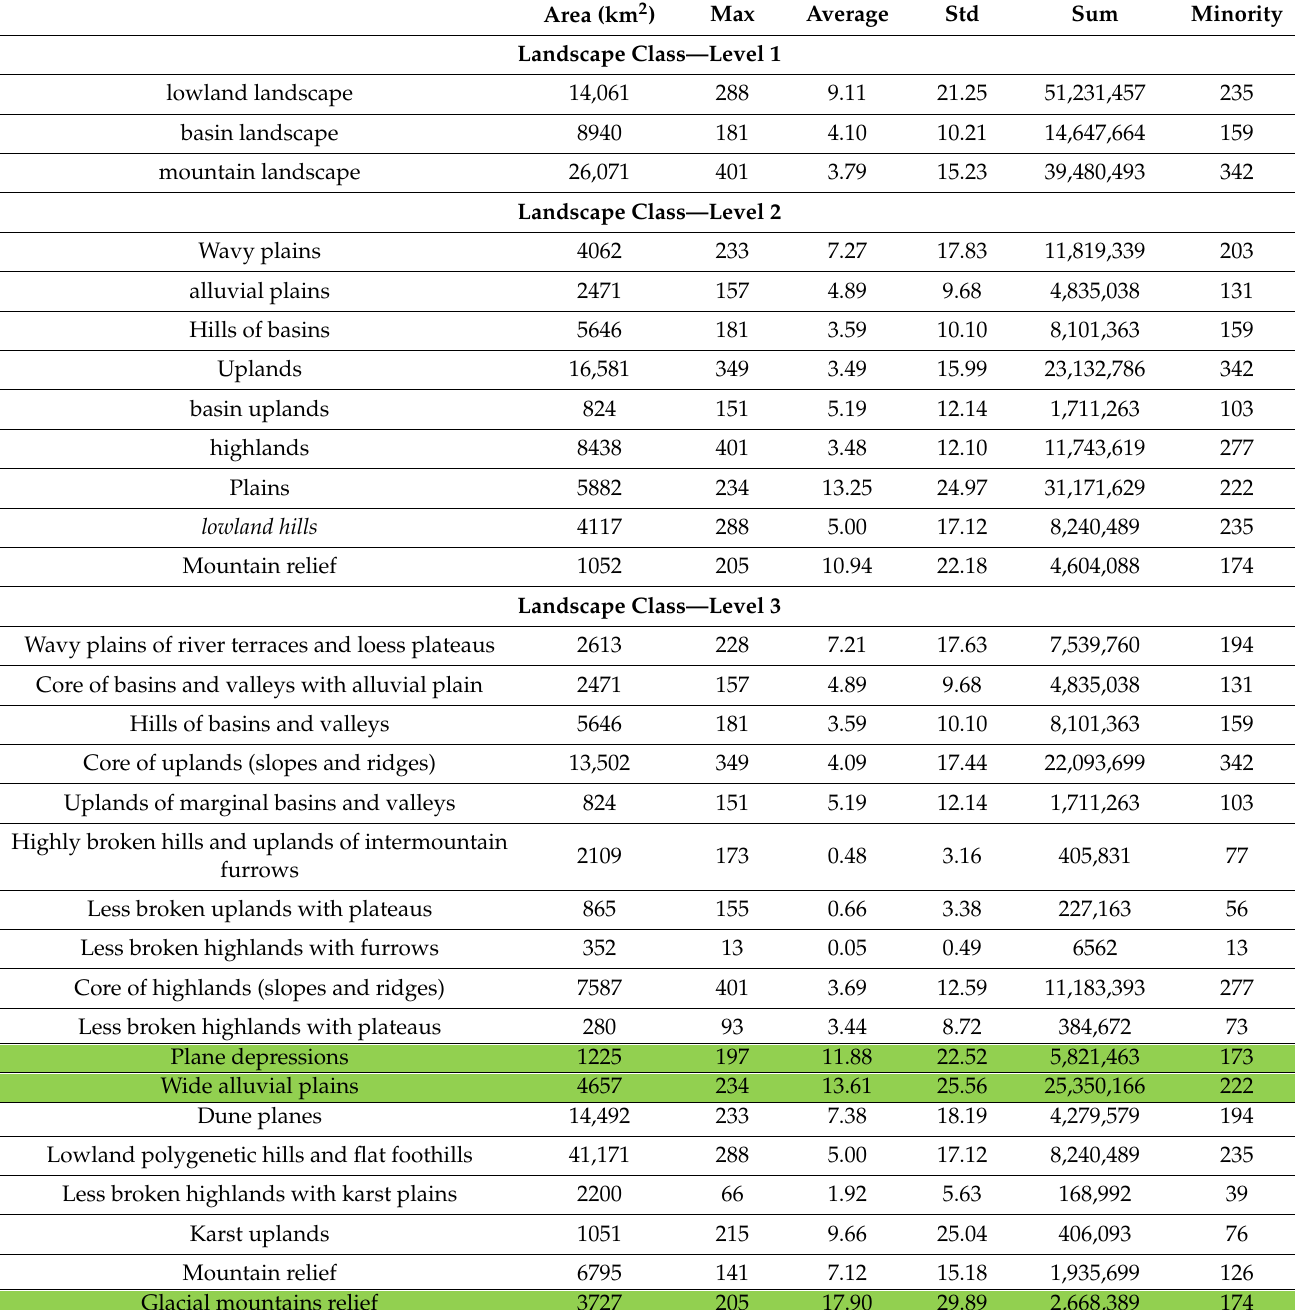
Table 2. Extent of land-use/land cover categories for each proposed norm (highlighted in green the most frequent categories with higher average values of visibility). Area (km 2 ) Max Average Std